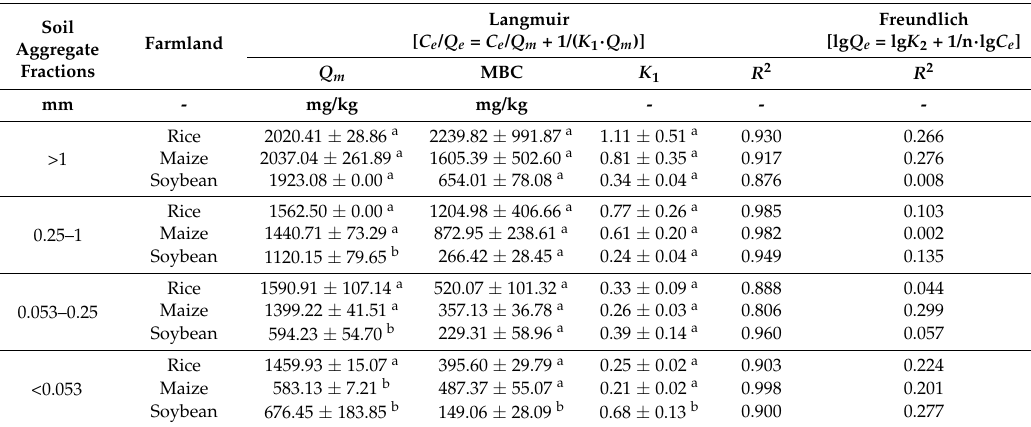
Table 2. The results of adsorption isotherm simulation.